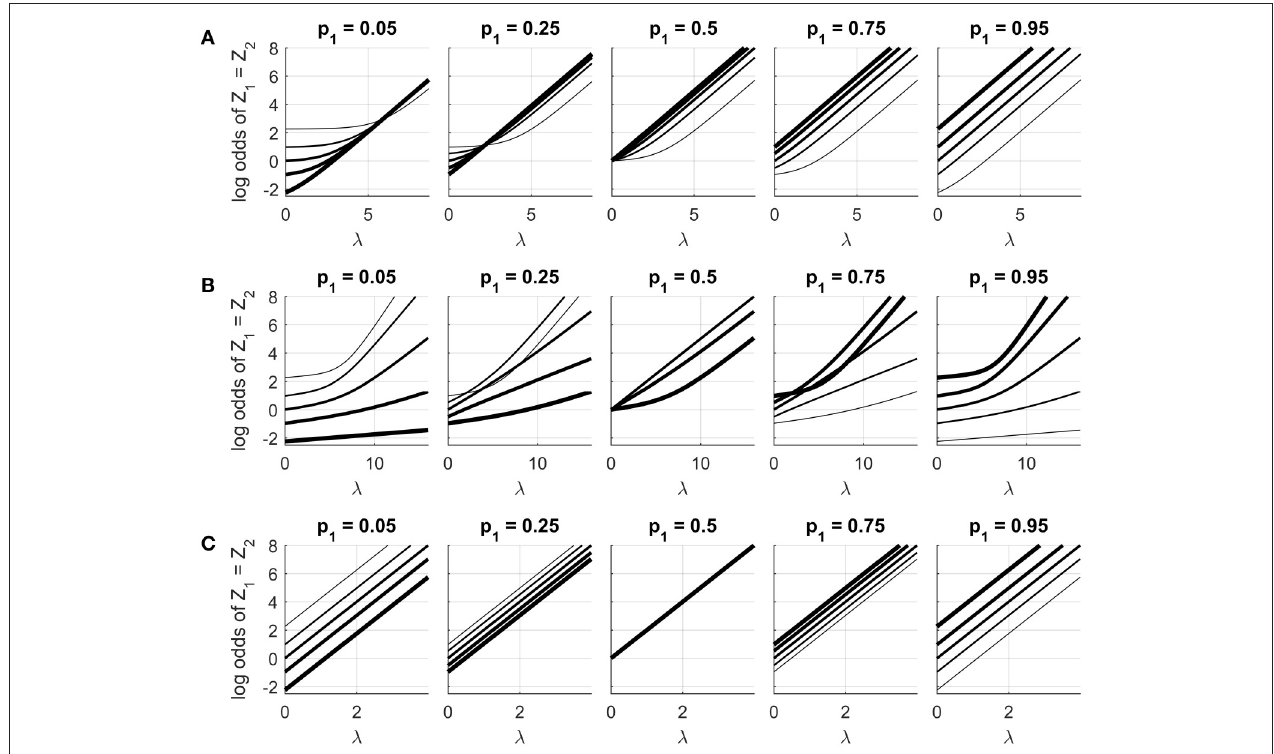
Z 1 Z 2 when n 2, as a function of λ at different ( p 1 , p 2 ) combinations for (A) the S 0,1 model, (B) the C 0,1 model, and (C) the { = } =